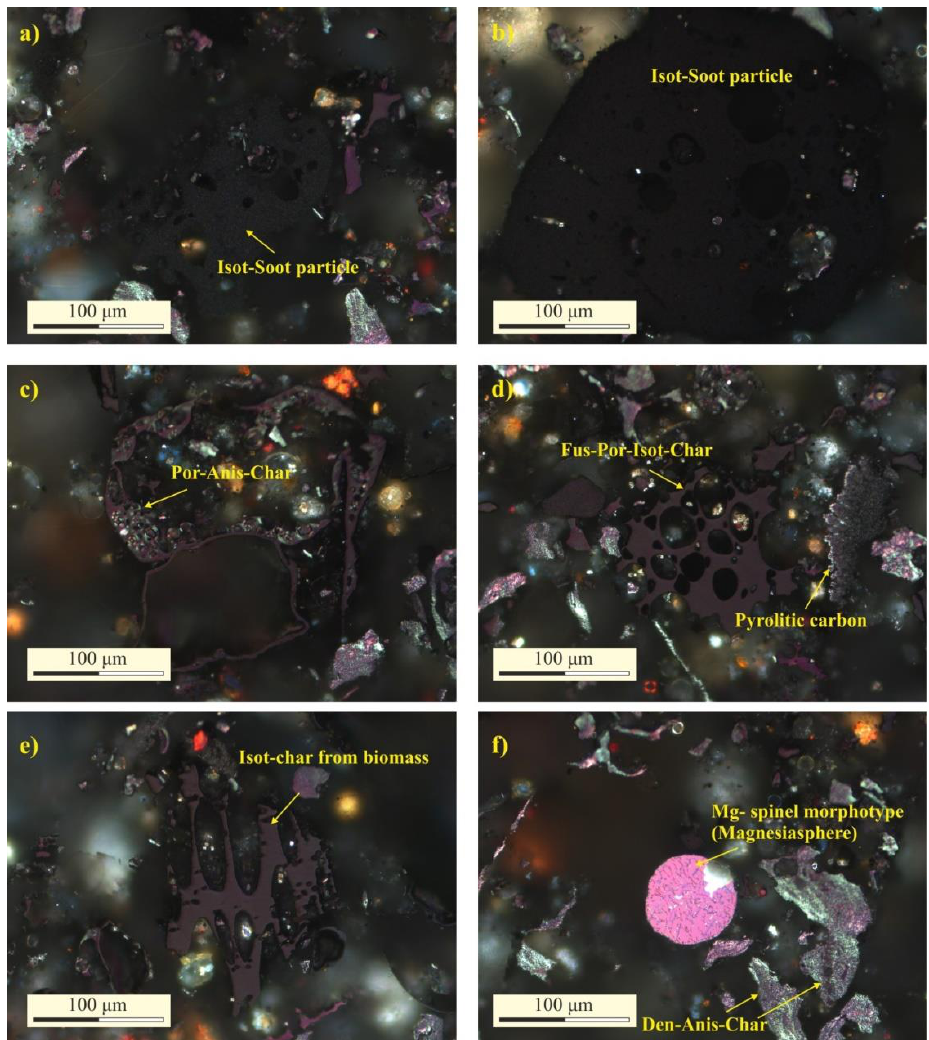
Figure 5. Exemplary photomicrographs ( a – f ) of the char particles in the FA (SRF) sample. (Fus: fused; Unf: unfused; Por: porous; Den: dense; Isot: isotropic; Anis: anisotropic).